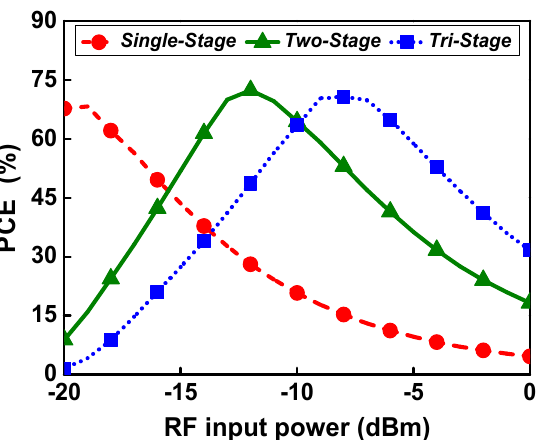
Figure 2. PCE according to the RF input power of rectifiers with a different number of stages.